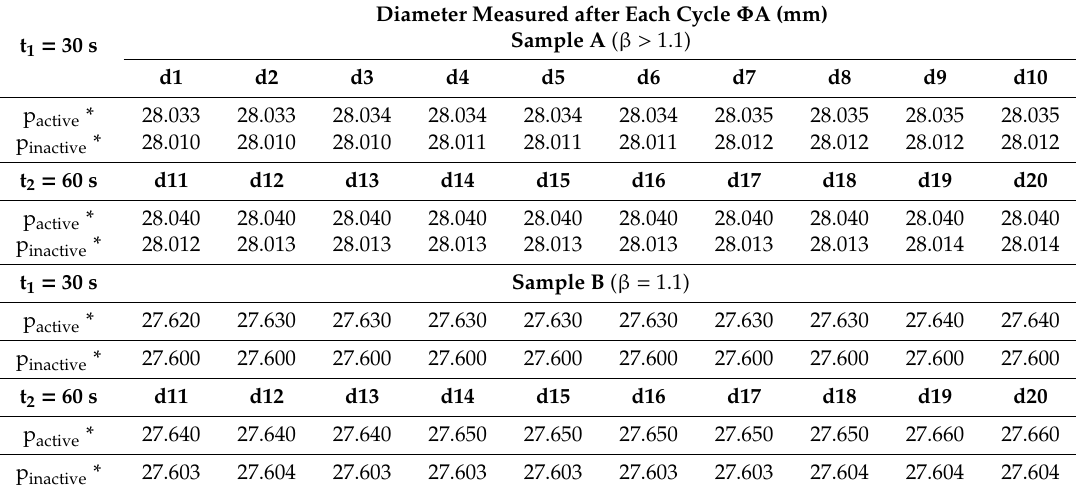
Table 5. The results of the cyclic loading test for all three types of specimens.